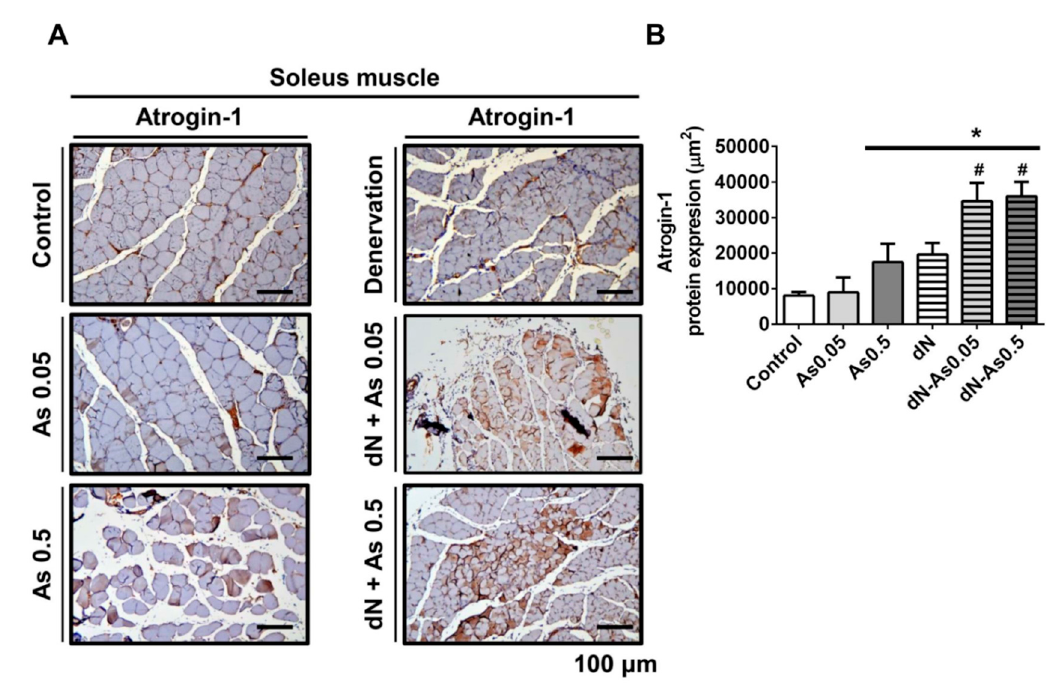
Figure 5. E ff ects of As 2 O 3 on the immunohistochemical change of Atrogin-1 expression in soleus muscles of mice with or without denervation. As 2 O 3 (0.05 and 0.5 ppm) exposure from drinking water for 4 weeks in normal mice or denervated mice. ( A ). The representative immunohistochemical images for the expression of Atrogin-1 in the soleus muscles isolated from As 2 O 3 -treated mice with or without denervation were shown. Scale bar = 100 µ m. ( B ). The quantitative analysis of immunohistochemistry was shown. Data are presented as the mean ± SEM ( n = 6 of each group). * P < 0.05 compared to the control group; # P < 0.05 compared to the denervation group.